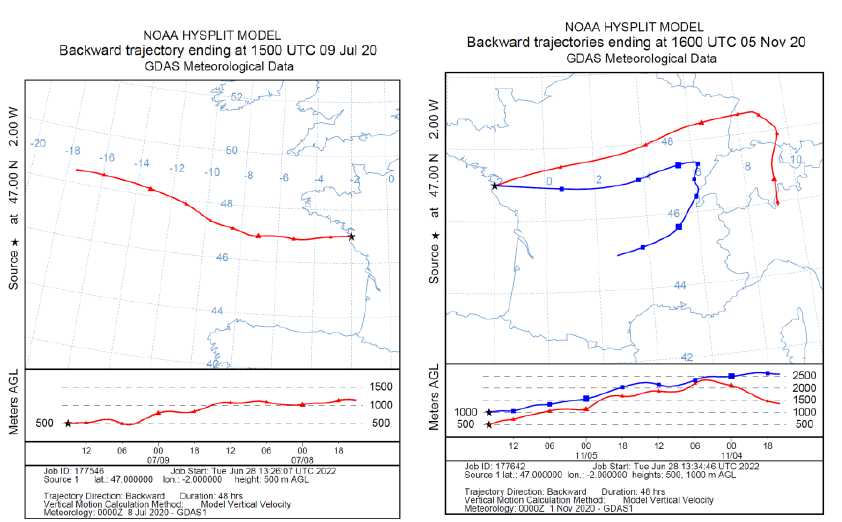
Figure 3. Air mass backtrajectories recorded during aerosol samplings made at Le Croisic in July (C4, left ) and November 2020 (C5, right ).